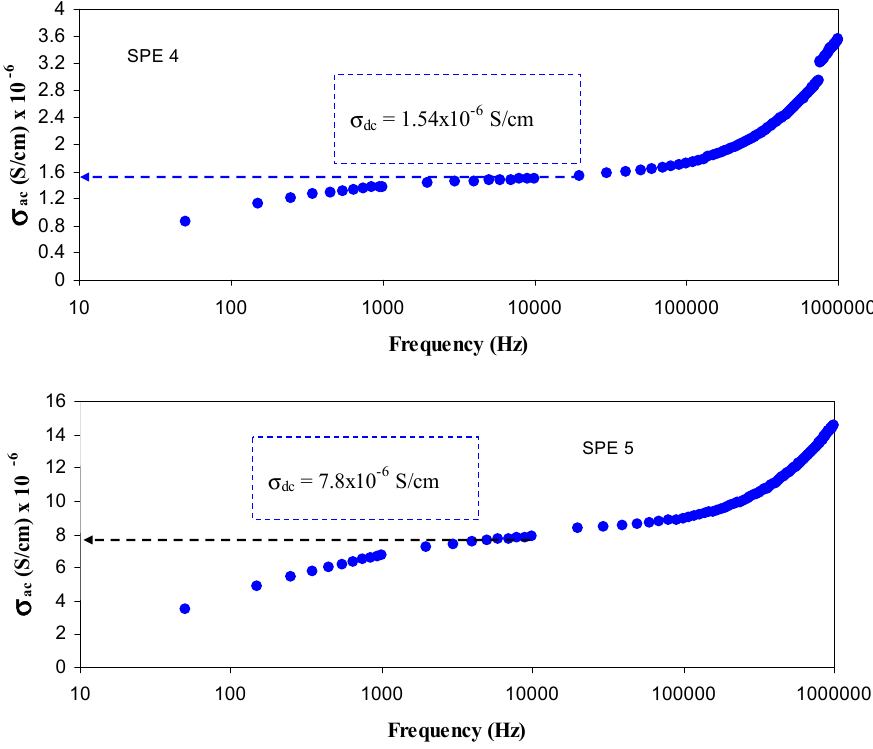
Figure 5. AC conductivity versus frequency for PVA:AgNt (SPE1 to SPE5) samples. The tail observed at low frequencies are ascribed to electrode polarization and the frequency independent plateau region of the conductivity is related to the DC conductivity and shifted to higher frequency side with increasing salt concentration.